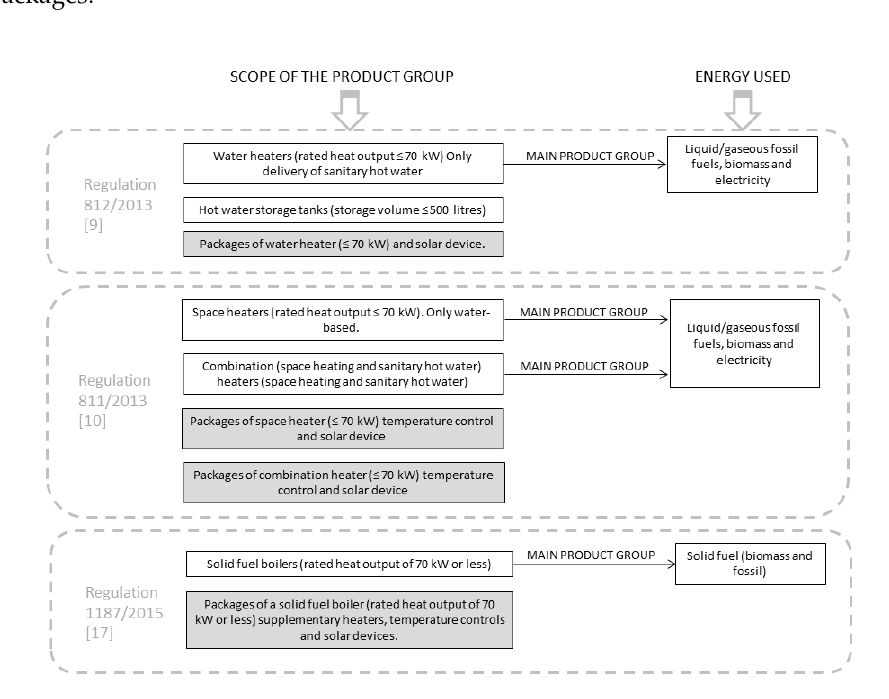
Figure 3. Scope of the EU Regulation which include the package concept.